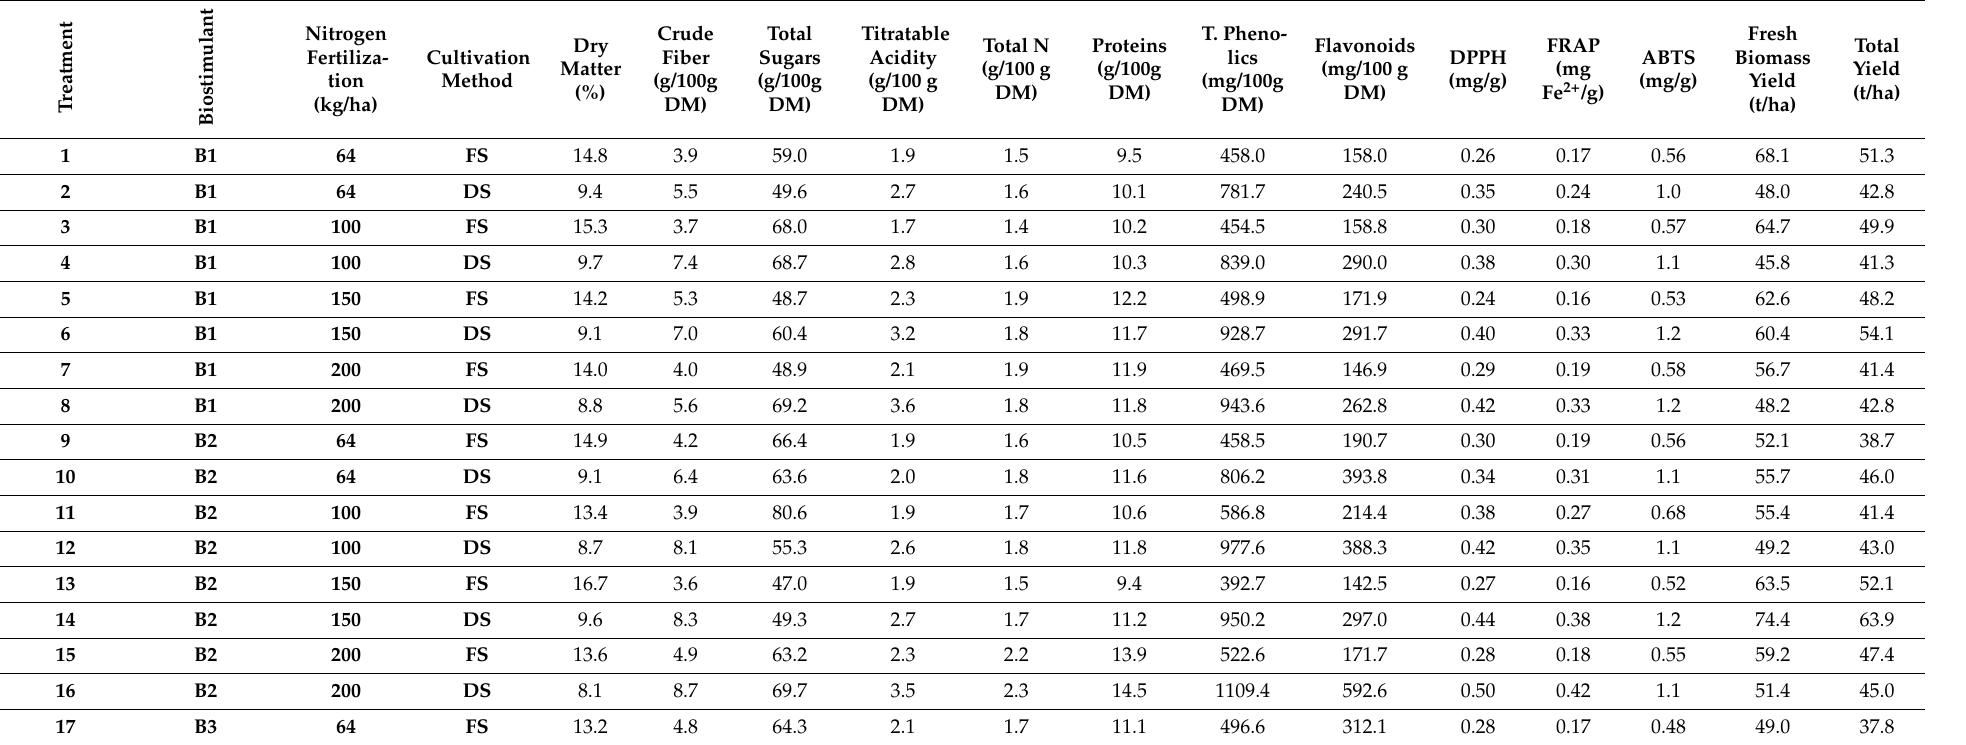
Table 1. Concentration of bioactive compounds, antioxidant activity and yield of onion bulbs (B1-HumiBlack, B2-Tifi, B3-Agasi, C-control, FS-from sets, and DS-directly seeded). The results are expressed as the means of three independent